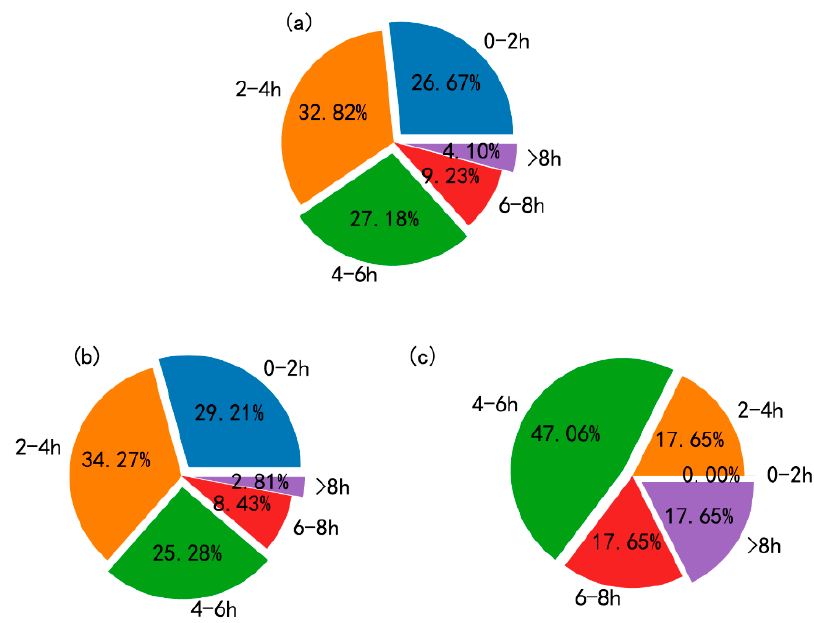
Figure 7. The lifespans (unit: hours) of ( a ) LCDM, ( b ) NoOut-Type and ( c ) Out-Type during the warm seasons (from April to September) of 2014–2018.